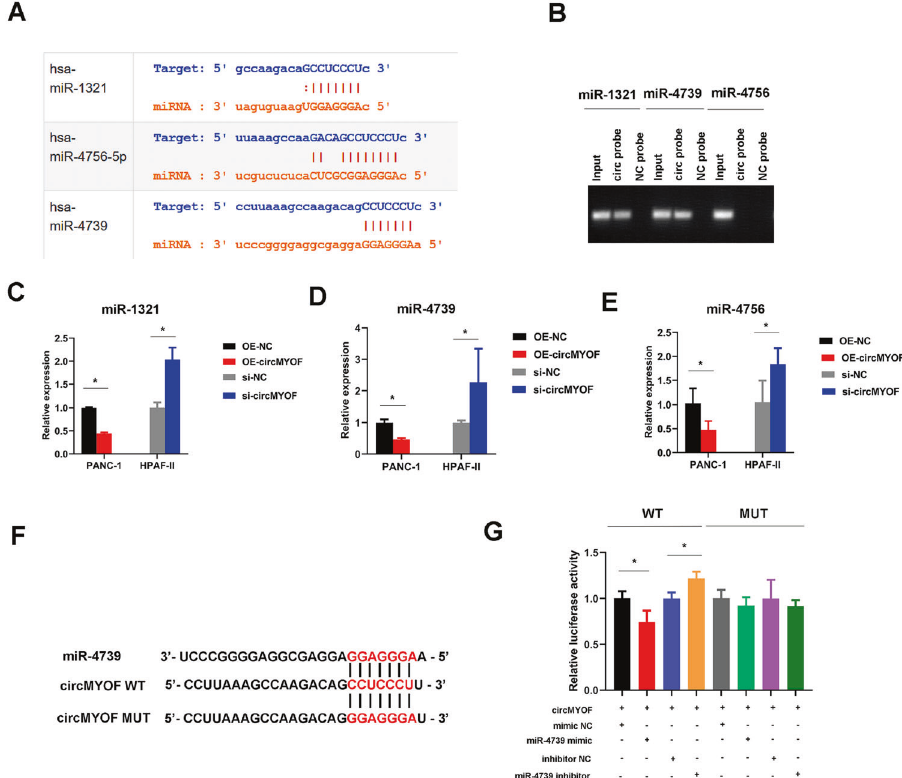
Fig. 6 CircMYOF acts as a sponge to miR-4739. A Three miRNAs (miR-1321, miR-4756, and miR-4739) were selected as circMYOF downstream targets by using the StarBase v2.0 database. B RNA pulldown assay indicated that the biotin-labelled circMYOF probe enriched miR-4739 the most. C – E Real-time PCR demonstrated that circMYOF knockdown enhanced miR-4739 expression and that circMYOF overexpression attenuated miR-4739 expression ( D ) more obviously than miR-1321 ( C ) or miR-4756 ( E ). F Schematic image showing the construction of luciferase reporter vectors with the wild-type or mutant 3 ′ untranslated region. G Luciferase reporter assay illustrated that the miR-4739 mimic signi fi cantly inhibited the luciferase activity of wild-type cells, while the miR-4739 inhibitor increased the luciferase activity of wild-type cells. Data are presented as the mean ± SD. All data was evaluated in three independent experiments. * p <